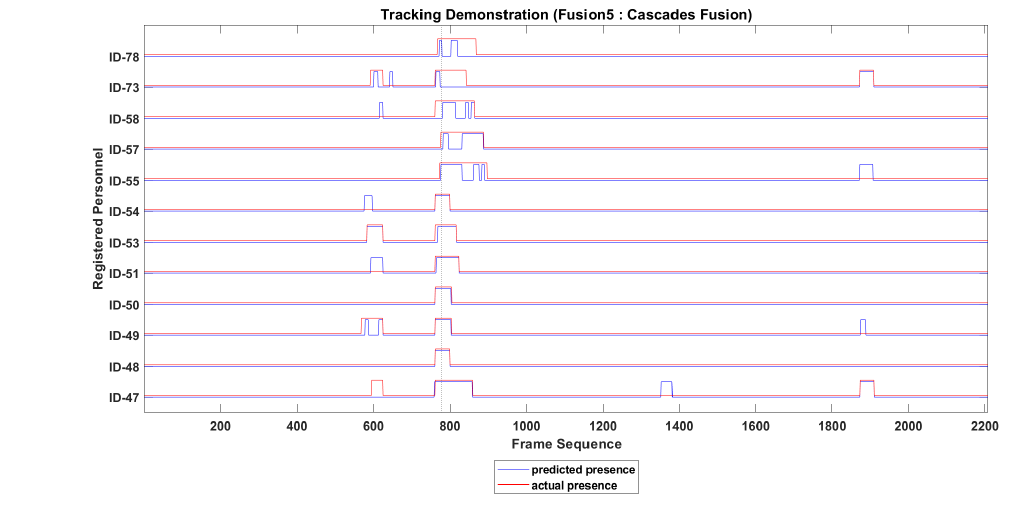
Figure 10. IDs tracking after smoothing over time